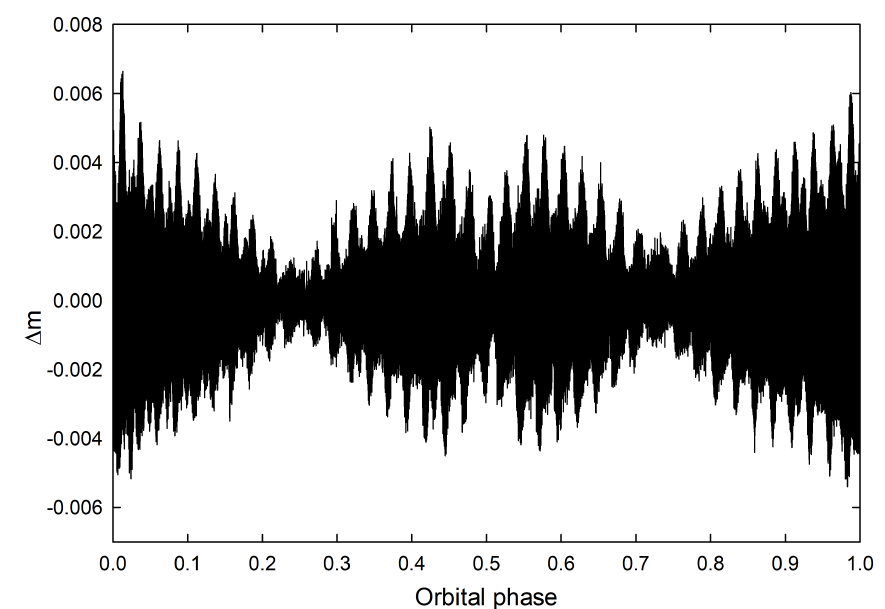
Figure 5. Variation of observed pulsation amplitude in V1031 Ori over an orbital period, caused by tilted l = 1, m = 0 nonradial pulsations. The maximum pulsation amplitude is reached at phase 1.0, when the pole of the pulsation axis is directed towards the observer. The expected maximum of the pulsation amplitude at phase 0.5, when the opposite pulsation pole is visible, is actually replaced with a minimum because of the PSF effect hitch is caused by the transit of the primary non-pulsating component in front of the pulsating secondary